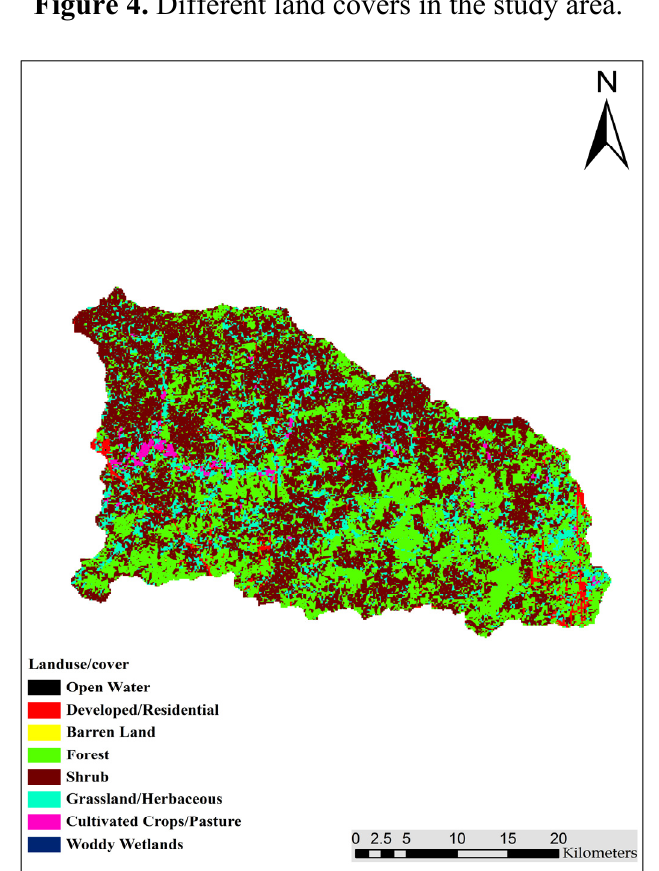
Figure 4. Different land covers in the study